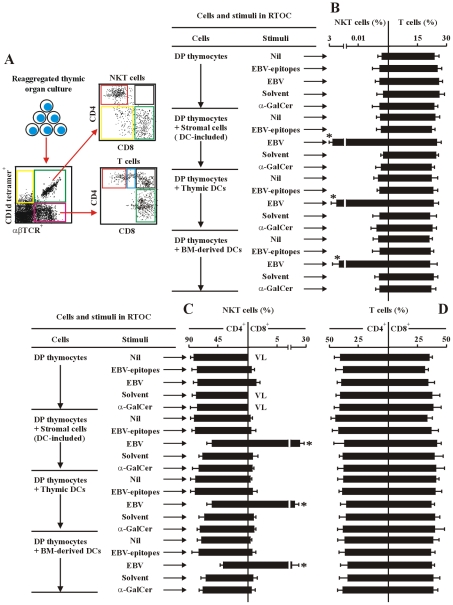
EBV-induced CD8+ NKT cell differentiation depends upon thymic dendritic cells.(A) The experimental and analysis scheme for detecting co-receptor-expressing NKT cells and T cells in various reaggregated fetal thymic organ cultures (RTOCs). After 14-days of culture, the various cell types were identified by flow cytometry as in Figure 2. (B–D) Frequency of total NKT cells and total T cells (B), co-receptor-expressing NKT cells (C) and T cells (D), in the different RTOCs. The protocols for the establishment of the RTOCs were described in the leftmost panels in each sub-figure: DP thymocytes were reaggregated with either total thymic stromal cells (DC-included), purified thymic dendritic cells, or BM-derived dendritic cells. The stimuli were added as indicated. Nil, no stimulus; EBV-epitopes, HLA-A2-restricted, derived from the lytic cycle protein BMLF1 and HLA-DRB1-restricted, derived from nuclear antigen EBNA1 (10 µg/ml each); EBV, infectious EBV (107 pfu); Solvent, 0.005% polysorbate 20; α-GalCer (0.1 µg/ml). The RTOCs were harvested, and assessed by flow cytometry. Only the data for CD4+ and CD8+ NKT cells, and CD4 SP and CD8 SP T cells were shown. VL, very low level (below detectable level). Data were mean ± s.d. (n  =  10). *, p<0.001, EBV-challenged RTOCs vs. non-challenged RTOCs.